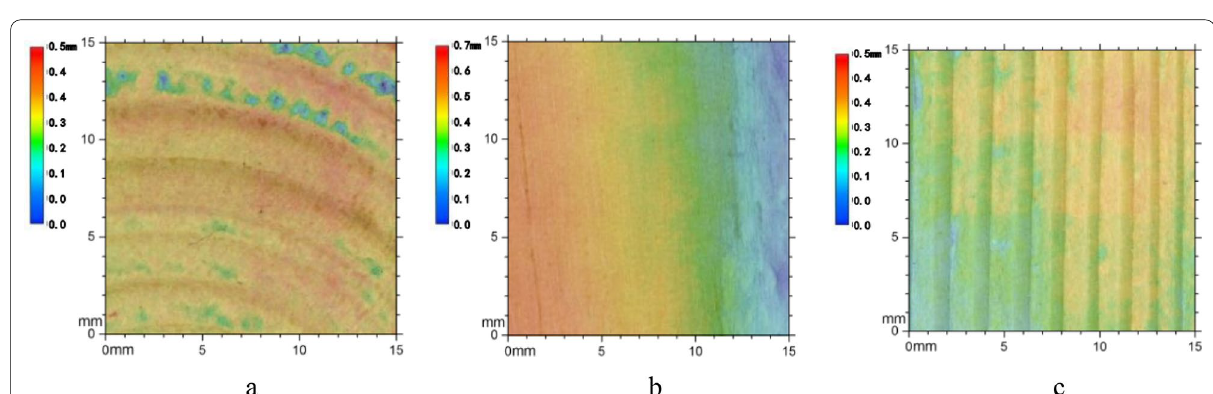
Fig. 10 3D profile of specimens with 200 mesh sandpaper grinding: a transverse section; b tangential section; c radial section